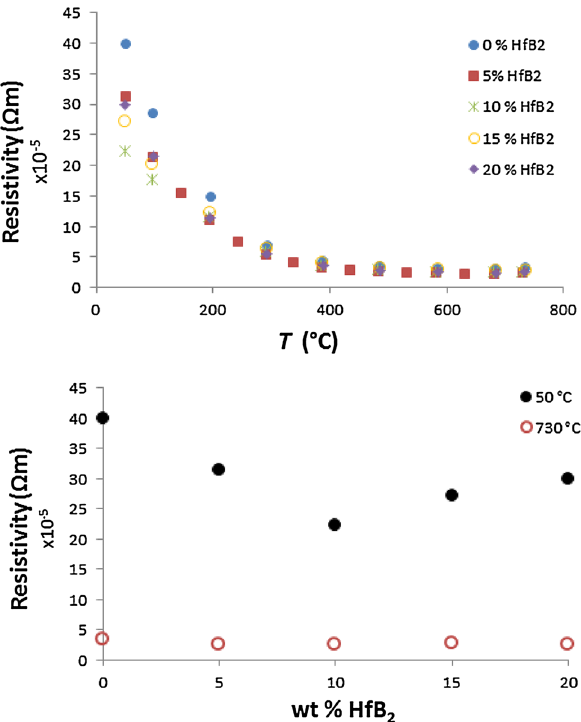
Fig. 4 Electrical resistivity as a function of ( top ) temperature and ( bottom ) hafnium diboride composition